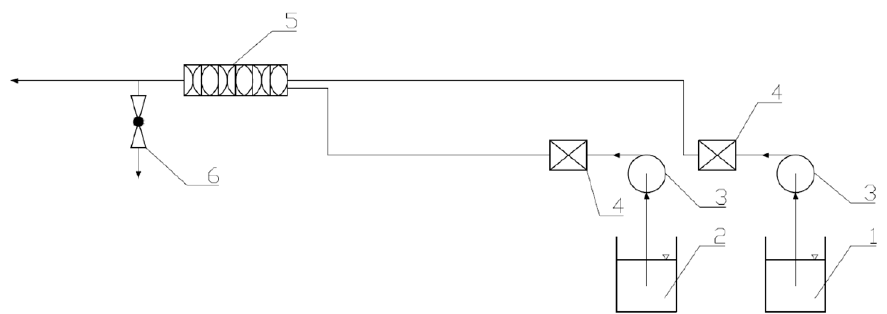
Figure 1. Laboratory installation: 1—tank with barium chloride solution; 2—tank with sodium sulfate solution; 3—peristaltic pump; 4—check valve; 5—multifunctional reactor (static mixer Kenics); 6—valve.